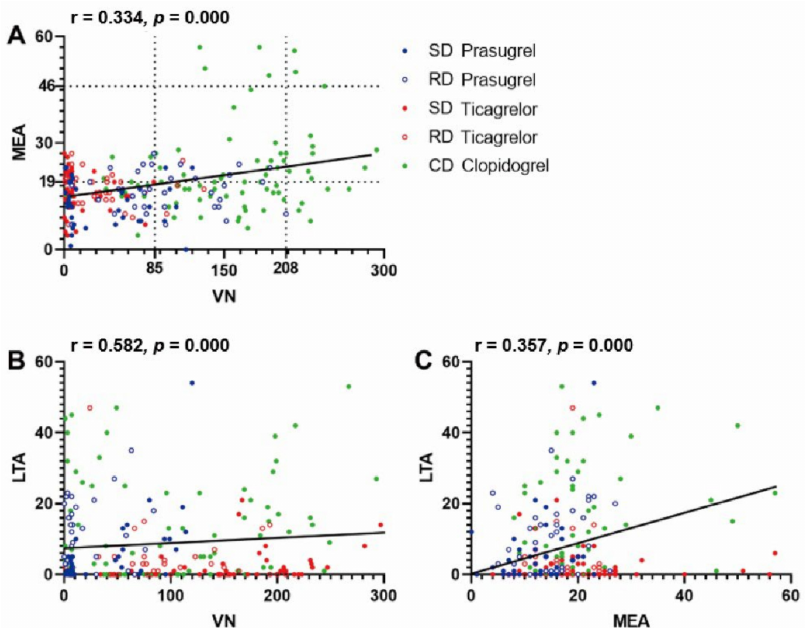
Figure 3. Correlation between three different platelet function tests (( A ). VN and MEA; ( B. ) VN and LTA; ( C ). MEA and LTA). SD: standard dose; RD: reduced dose; CD: conventional dose; VN: VerifyNow; MEA: multiple electrode aggregometry; LTA: light transmittance